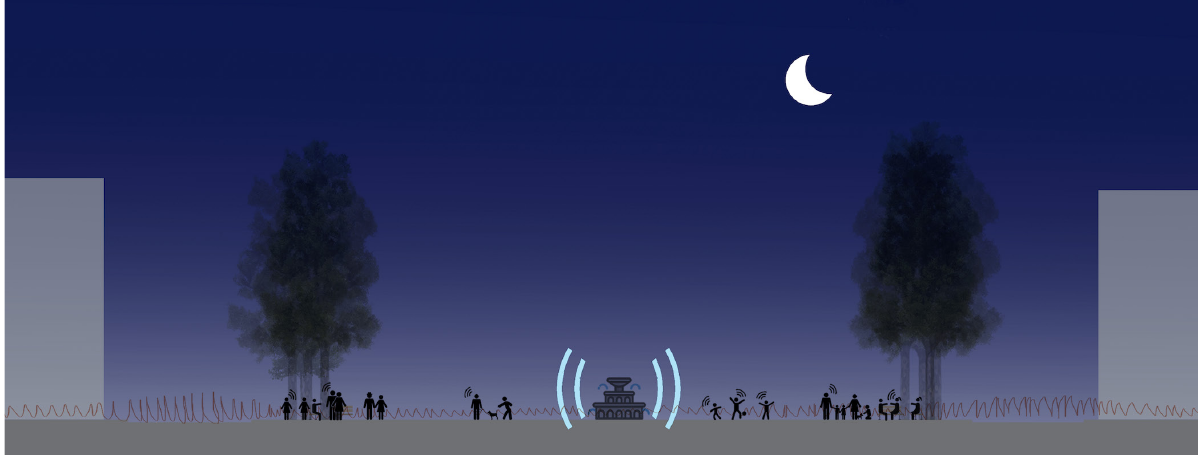
Figure 7: The sounds of the Piazza at night, August 2017, 23 pm. The observation lasted 40 min. The only differences seem to be no birds, and the sound of traflc appears very much